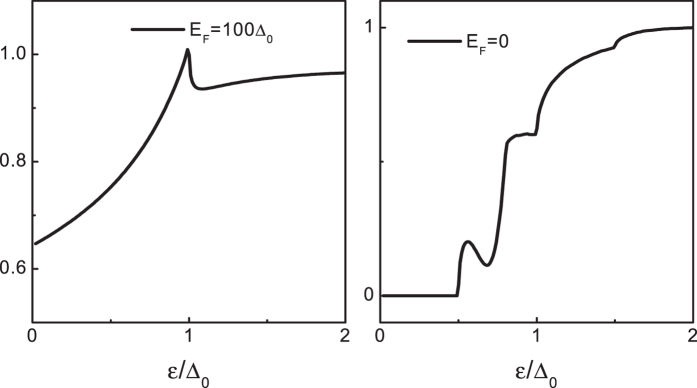
Normalized tunneling conductance GT = G−/G+ for the superconducting heterojunction with λ = 2β for EF = 100Δ0 (a) and EF = 0 (b).